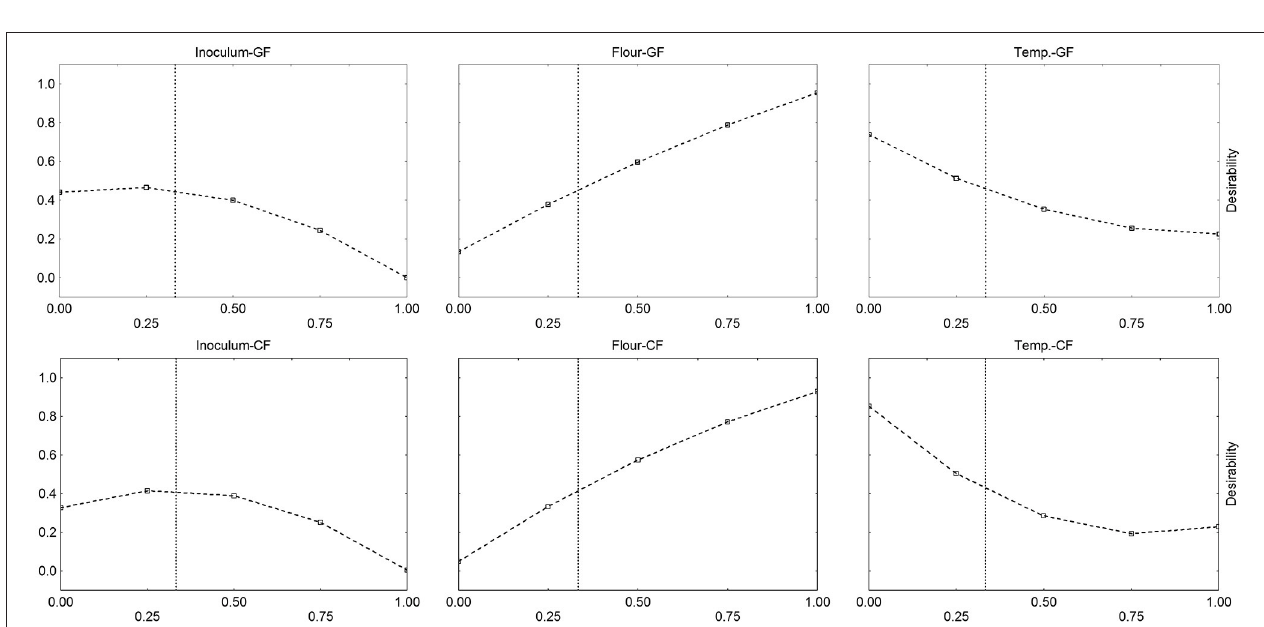
FIGURE 6 | Desirability profiles for the effect of flour (F), inoculum (I), and temperature (T) on the time before the beginning of acidification (parameter α ) of L. delbrueckii subsp. bulgaricus . GF, Gluten Friendly Flour; CF, Control Flour.